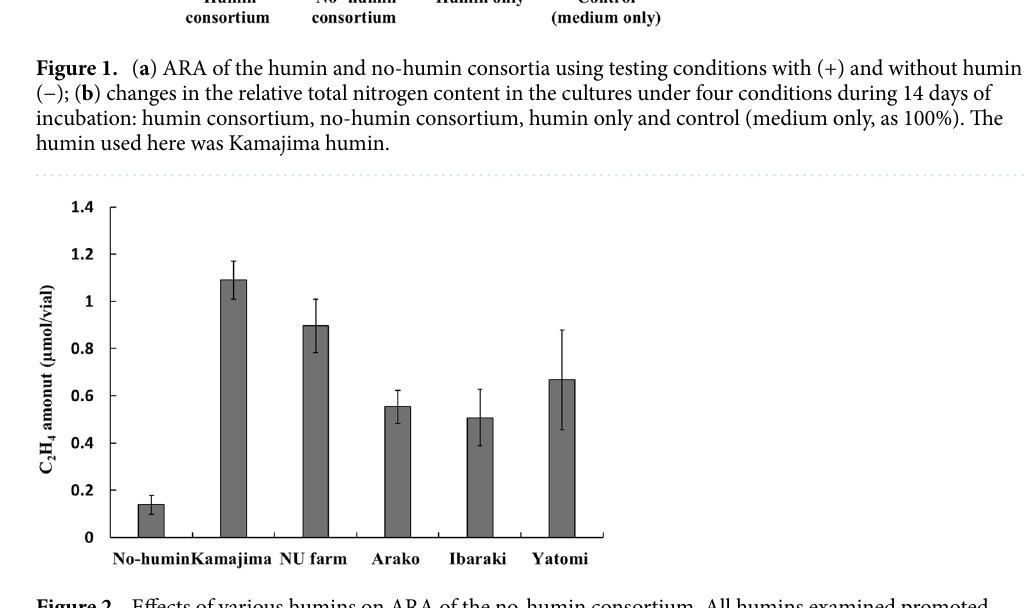
the same as that on day zero.